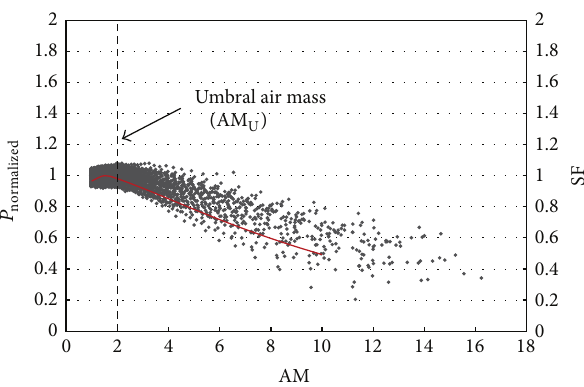
Figure 1: Normalized maximum power (grey dots) and spectral factor (red line) versus AM of a HCPV module made up of lattice-matched GaInP/GaInAs/Ge solar cells and poly(methyl- methacrylate) (PMMA) Fresnel lenses [14,